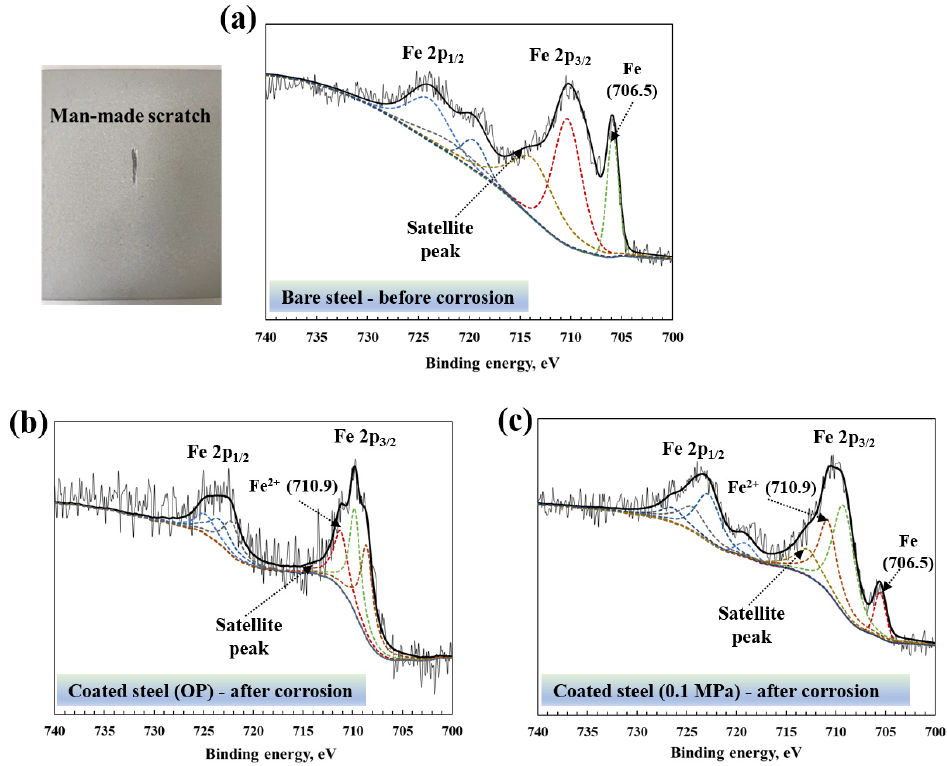
Figure 8. XPS spectrum of the ( a ) bare steel before accelerated corrosion and ( b , c ) the coated steel cured with different carbonation pressure after corrosion.